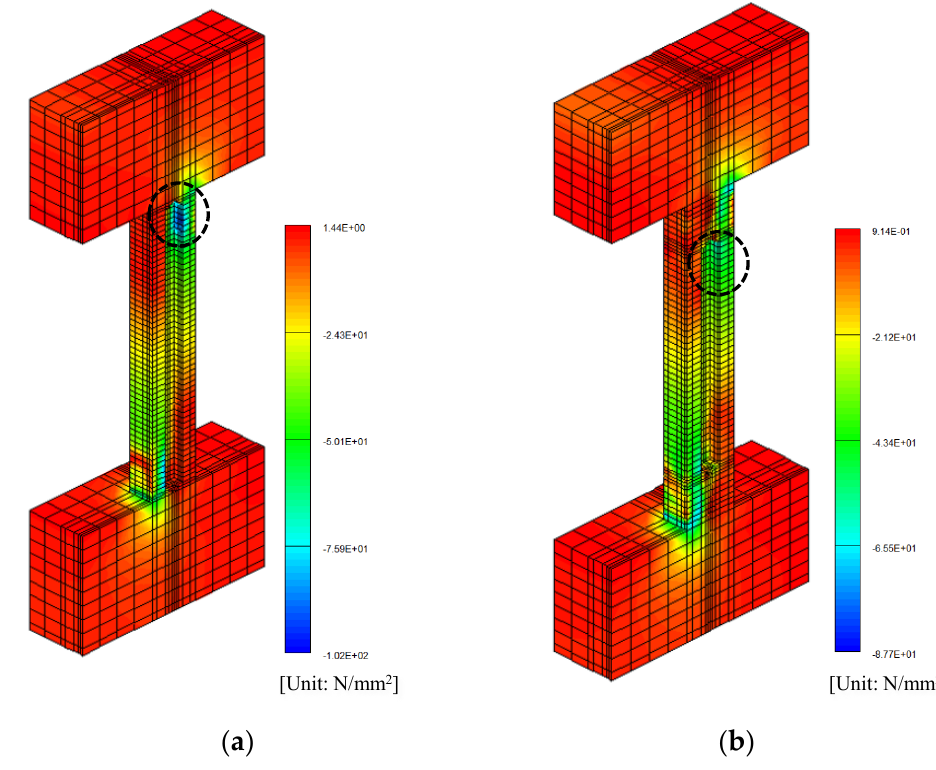
Figure 18. Minimum principal stress distribution of concrete ( R = 1.0%): ( a ) CM12; ( b ) CM13.